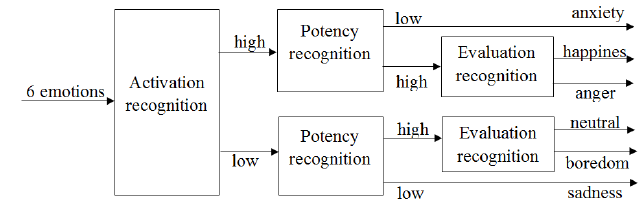
Fig. 2. Two-step hierarchical classification of two emotions